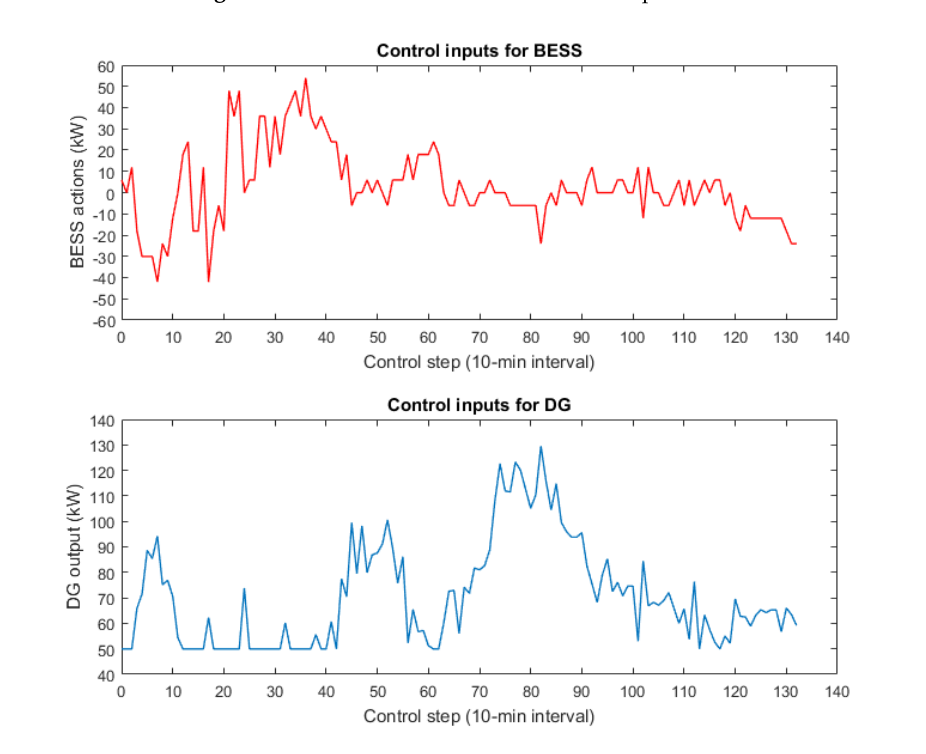
Figure 6. Simulation results of battery energy storage system (BESS) action and distributed generator (DG)